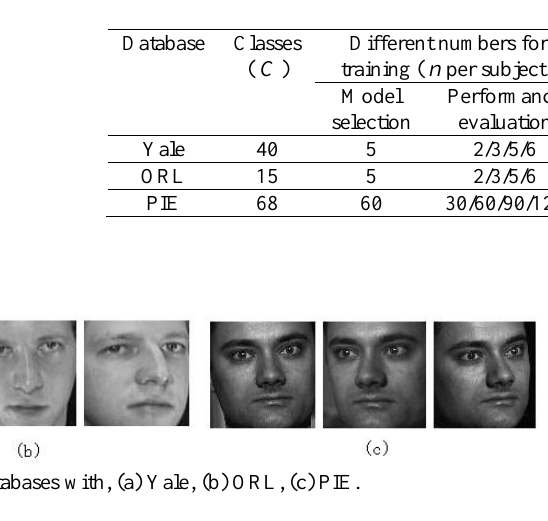
Table 1. Random partition on three databases for the